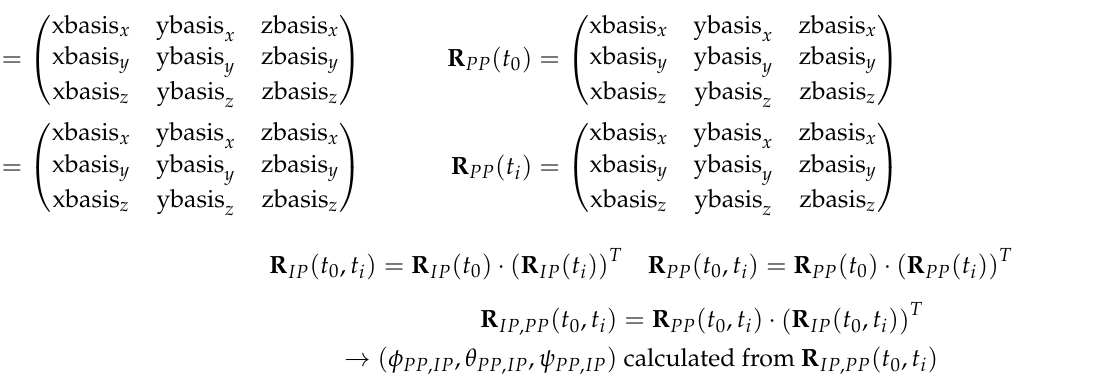
Figure 5. To obtain the angle φ PP , IP between the proximal phalanges (PP) and intermediate phalanges (IP) the angles φ IP and φ PP are needed. Consequently, first the angle φ IP will be calculated with the rotation matrix from R IP ( t 0 ) at the initial condition ( t 0 ) and R IP ( t i ) at the time step t i . Second, the angle φ PP will be calculated with the rotation matrix from R PP ( t 0 ) at the initial condition ( t 0 ) and R PP ( t i ) at the time step t i . The difference between φ PP and φ IP defines the required angle φ PP , IP . The calculation of the example as graphically illustrated in Figure 5 is applied to all finger